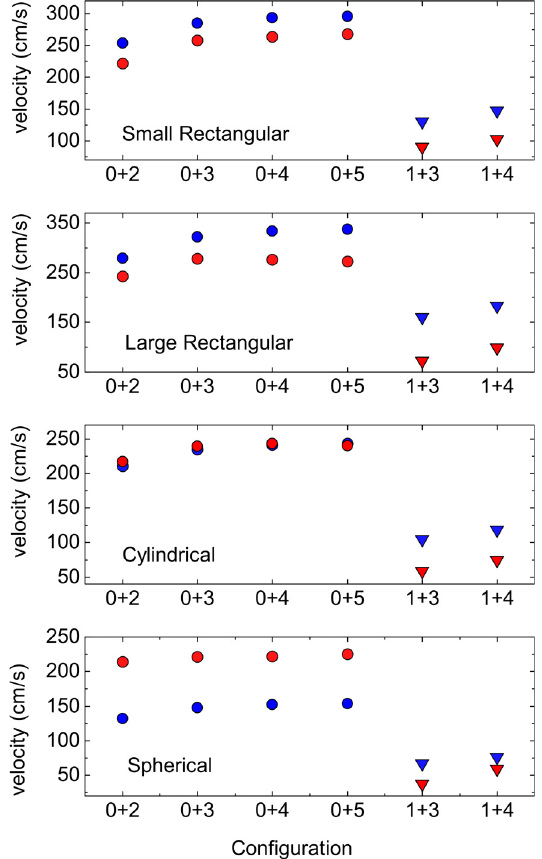
Fig. 3. The fi nal velocity for each of our magnets and for initial con fi gurations with up to a total number of 5 balls. The blue points are the theoretical values and the red points the experimental